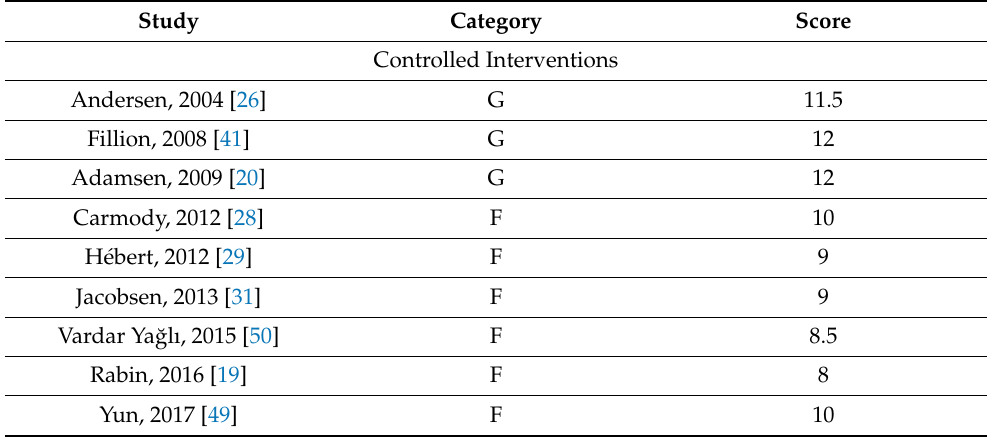
Table 4. Quality assessment